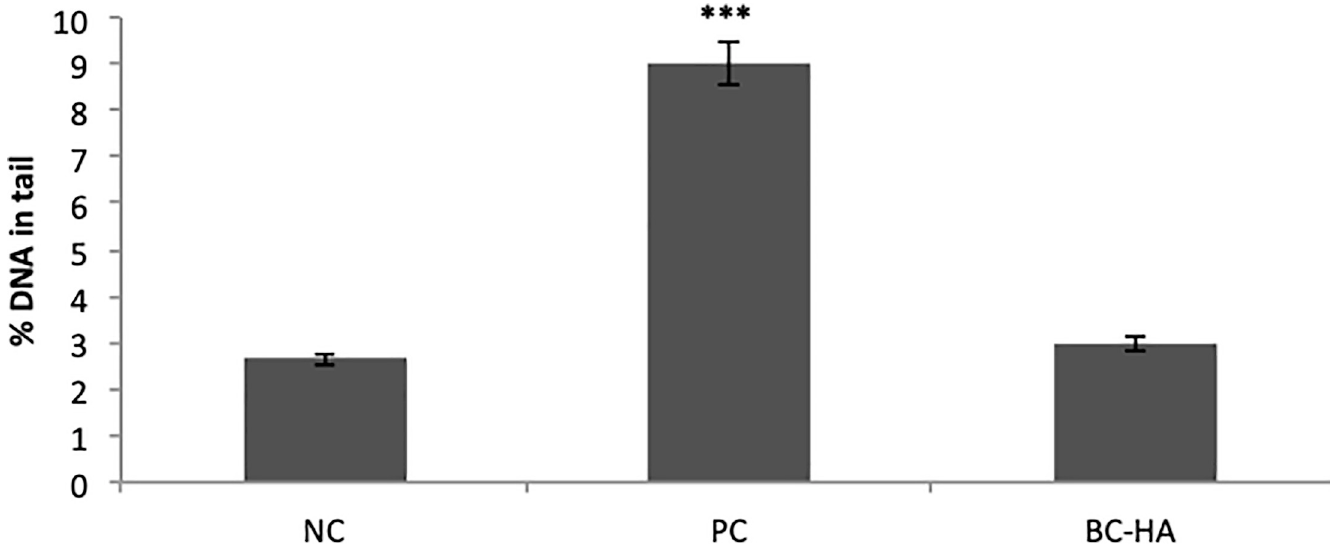
Fig 5. Genotoxicity assessed by the comet assay. Columns indicate mean percentage of DNA in the nucleoid tail. Bars indicate standard error. The ��� symbol indicates statistically significant difference compared to NC (p < 0.0001). Dunnett’s test.